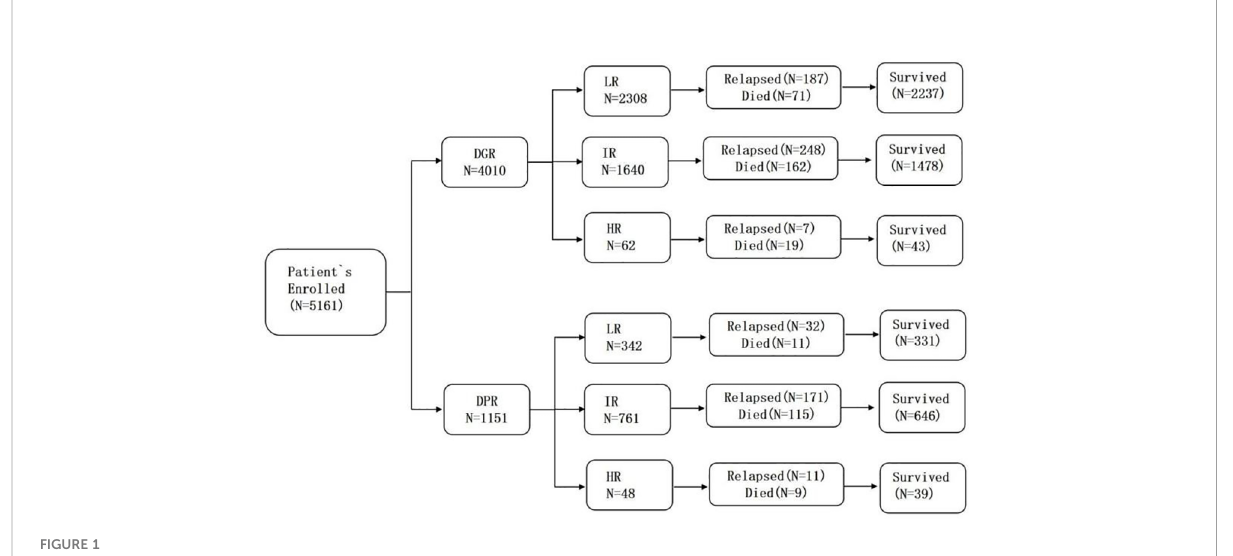
FIGURE 1 Flow chart of